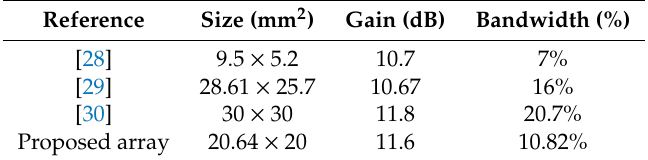
Table 6. Comparison between previously published work and the proposed antenna